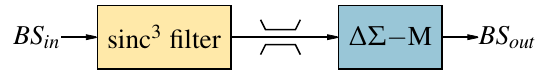
Figure 29. Limiting the the value of a bit-stream utilizing DSP.